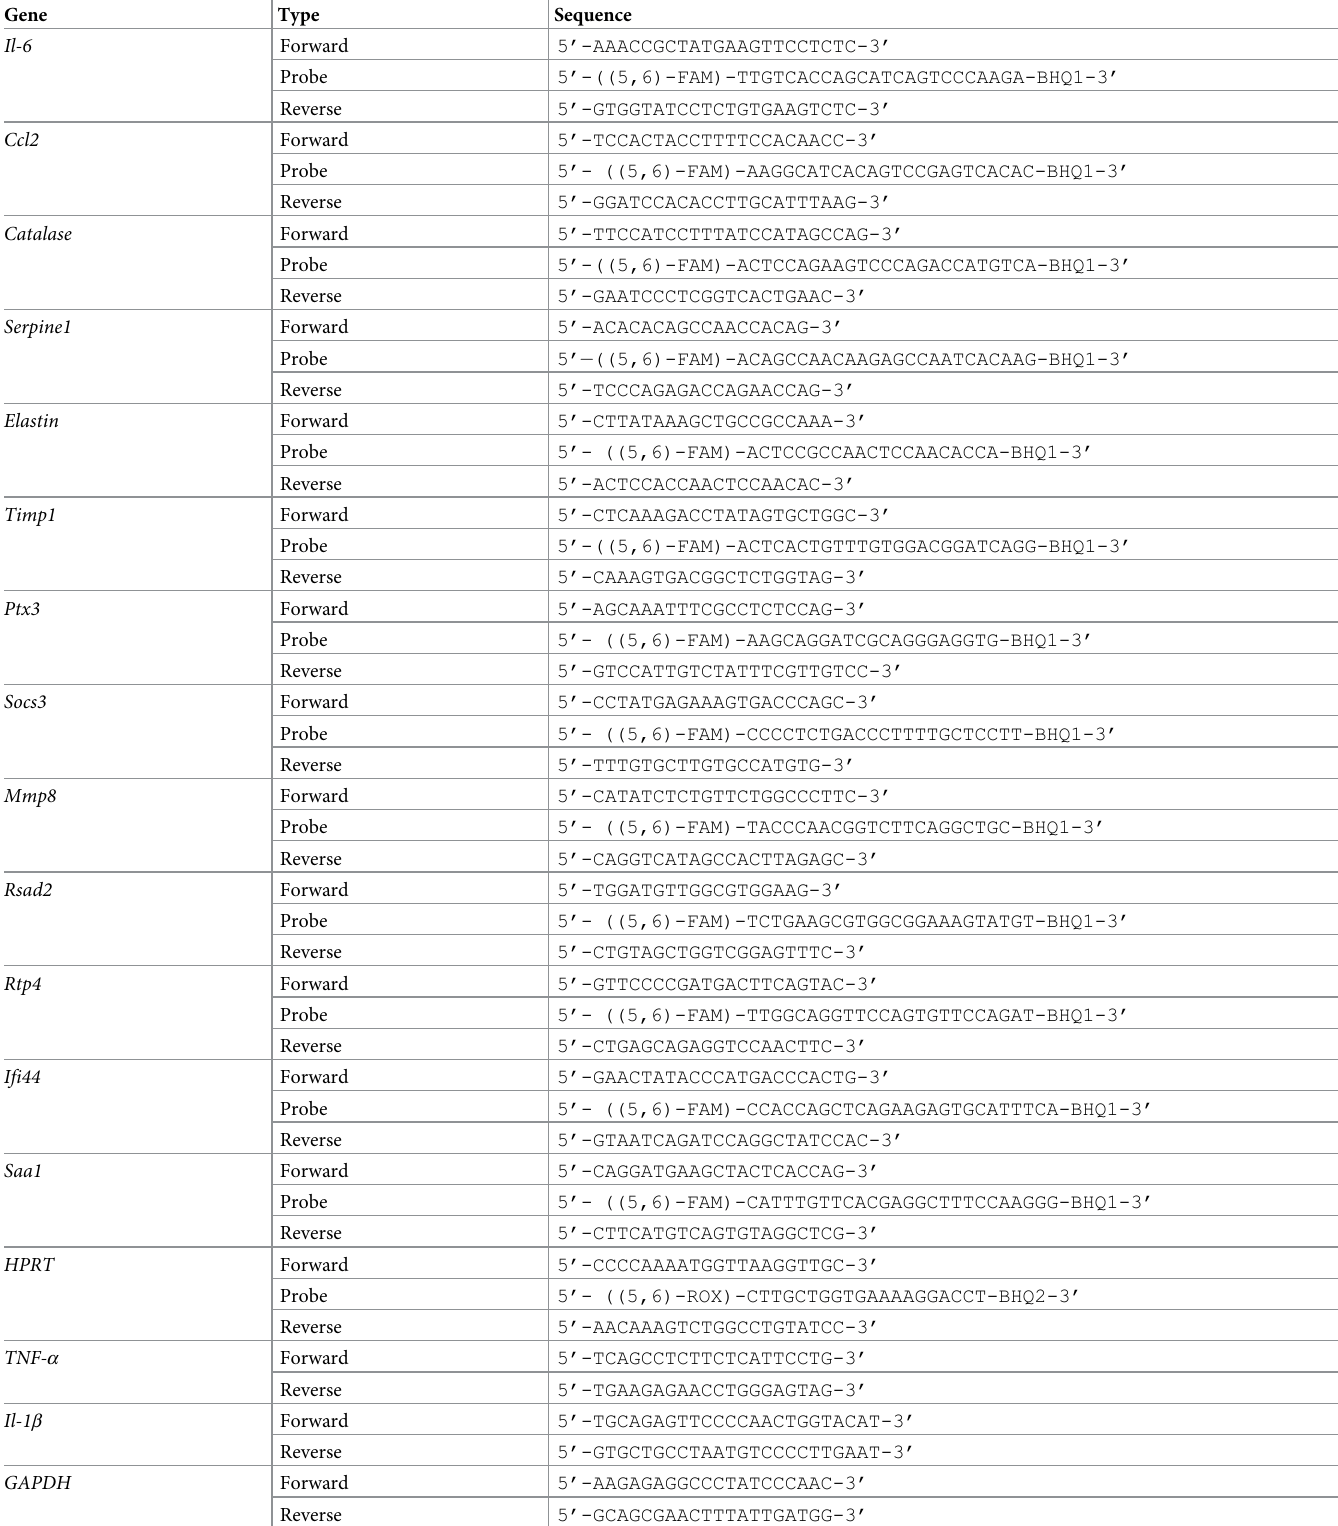
Table 1. The primers used in this